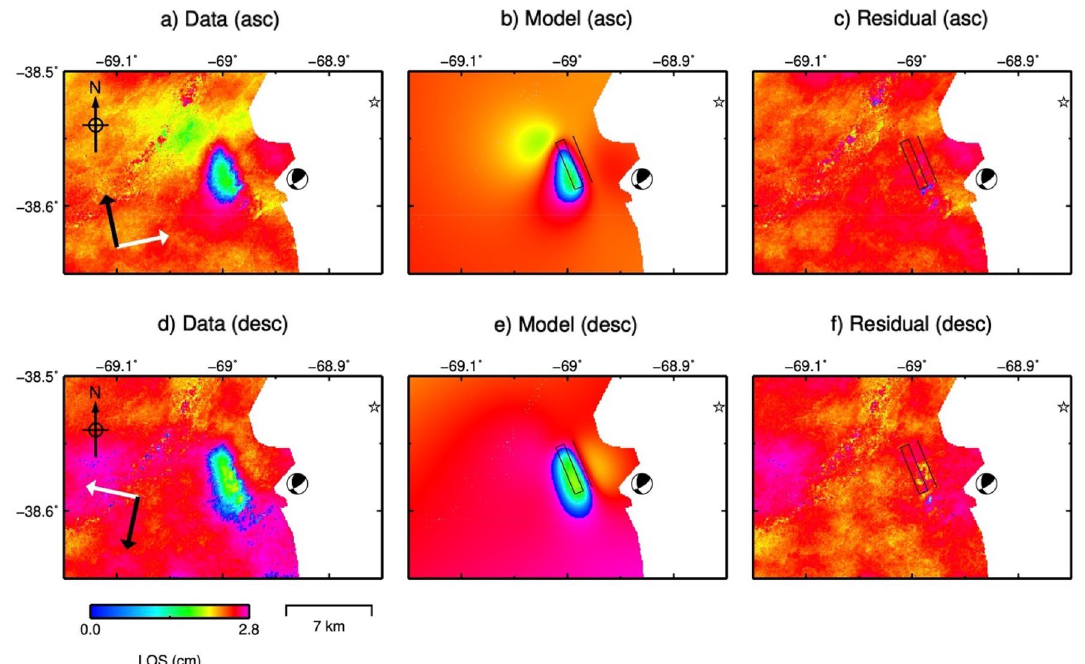
Figure 5. ( a ) and ( d ) Show coseismic Line-Of-Sight (LOS) deformation of the Mw 5, 2019 March 7 Neuquén basin earthquake obtained as the average of 11 coseismic ascending interferograms (in a) and as the average of 10 coseismic descending interferograms (in d ). The white arrows indicate satellite Line-of-Sight direction (LOS) and the black arrows indicates satellite azimuth (Az). ( b ) and ( e ) Show LOS deformation predicted by the forward model using the maximum a posteriori probability solution. ( c ) and ( f ) show the residuals. The black rectangle represents the outline of the optimal fault plane. The Global Centroid Moment Tensor (GCMT, www. globa lcmt. org/) is represented by the beach